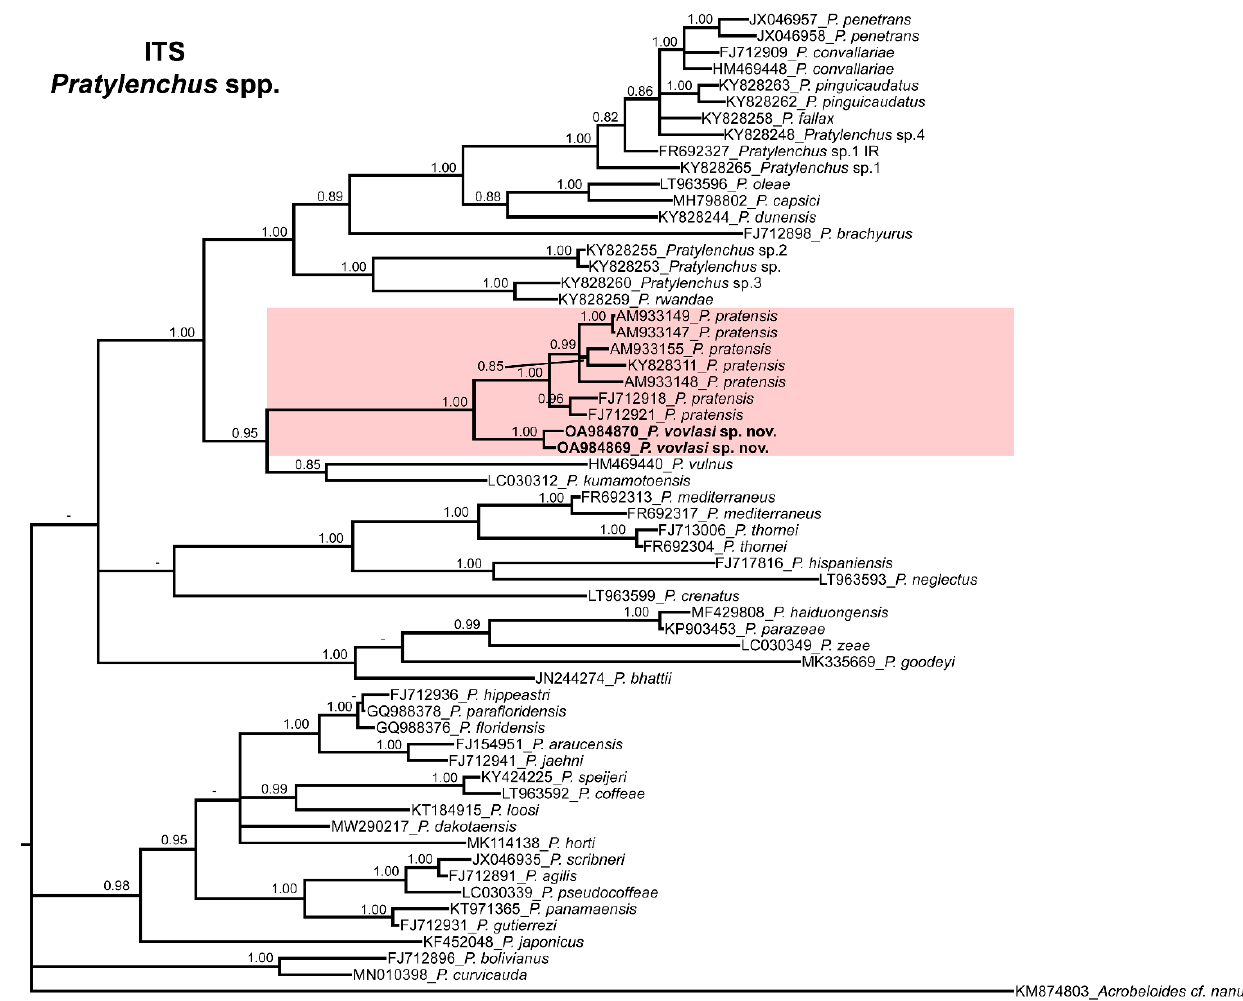
Figure 3. Phylogenetic relationships of Pratylenchus vovlasi sp. nov. within the genus Pratylenchus . A Bayesian 50% majority-rule consensus tree as inferred from the ITS sequence alignment under a transversional model with a proportion of invariable sites and a rate of variation across sites (TVM + I + G). Posterior probabilities more than 70% are given for appropriate clades. Newly obtained sequences in this study are in bold letters. Scale bar = expected changes per site.